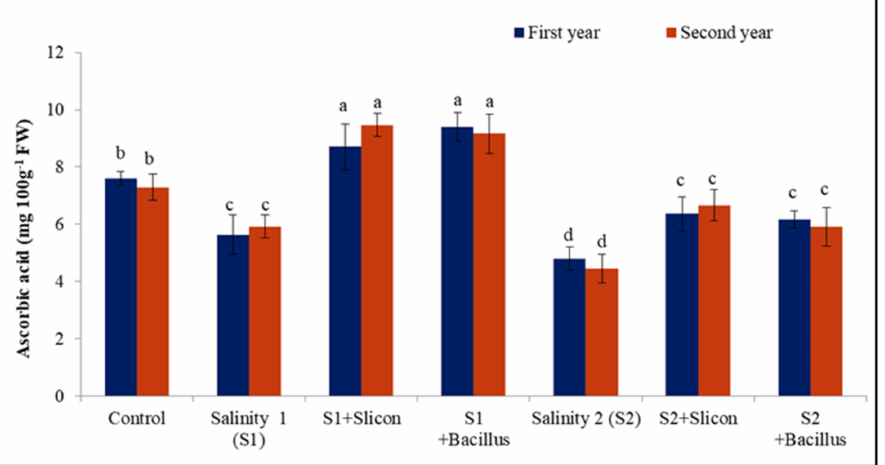
Figure 4. Effect of Si (potassium silicate at 2.7 mmol L − 1 ) and B. thuringiensis on Acorbic acid in lettuce plants under salinity during two seasons (2019/2020 and 2020/2021). Different letters on the columns show significant differences between the treatments according to ANOVA, Duncan’s multiple range test at 0.05 level. Data is the mean ( ± SE) of tree replicates. Salinity 1 (S1): 4 dS m − 1 Salinity 2 (S2): 8 dS m − 1